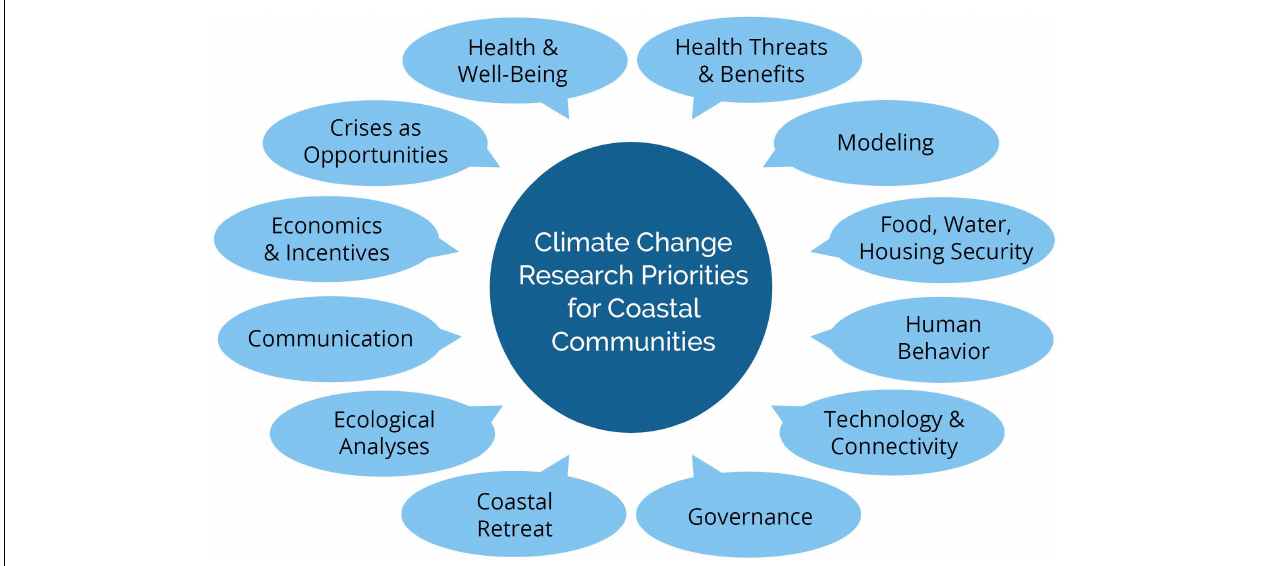
FIGURE 1 | Priority areas for climate change research to increase resilience of coastal communities in the United States and